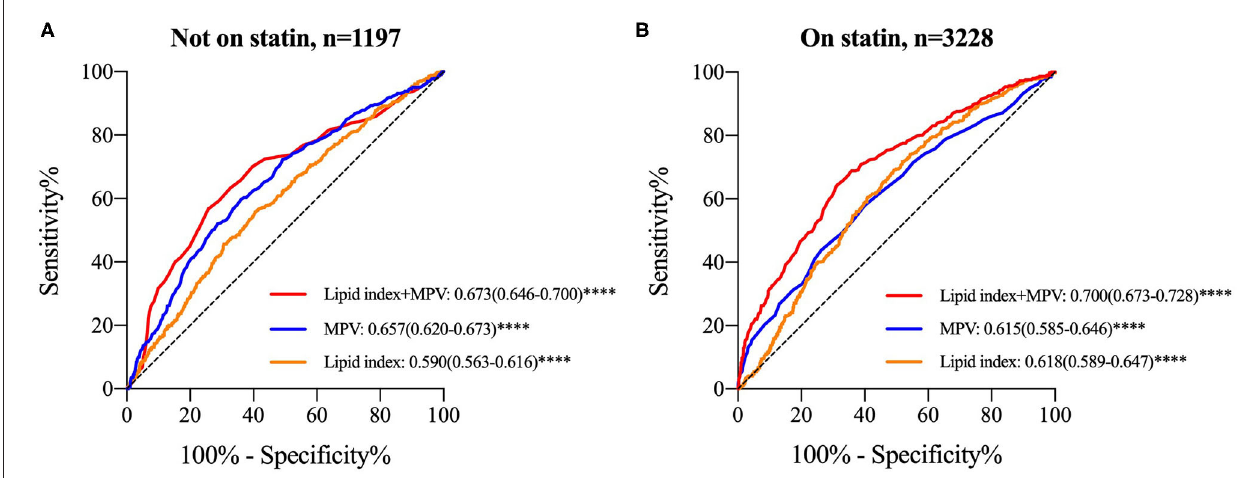
FIGURE 4 | ROC curves for lipid index, MPV and “lipid index + MPV” combination to determine high GS stratified by statin use. (A) ROC curve in subjects without statin therapy; (B) ROC curve in subjects with statin treatment. Data were expressed as AUC (95% CI) and **** P < 0.0001. ROC, receiver operating characteristic; GS, Gensini score; MPV, mean platelet volume; AUC, area under ROC curve; 95% CI, 95% confidence intervals.